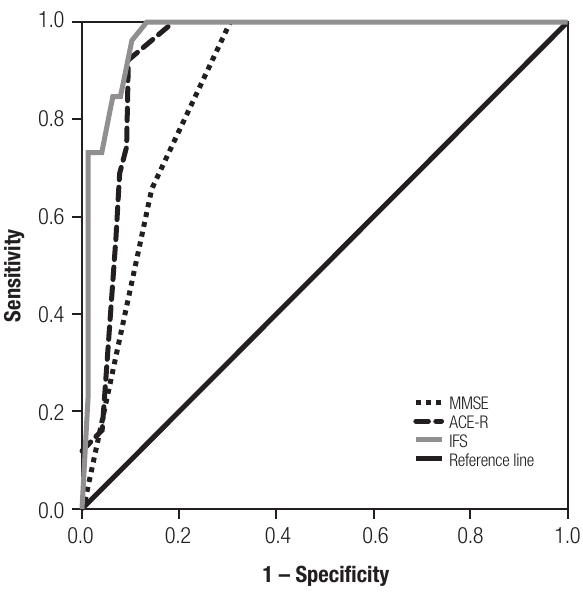
Figure 3. ROC curve for controls vs. patient groups (bv-FTD and depres- sion). The superior discriminatory accuracy of the IFS over the MMSE and ACE-R is revealed by its larger area under